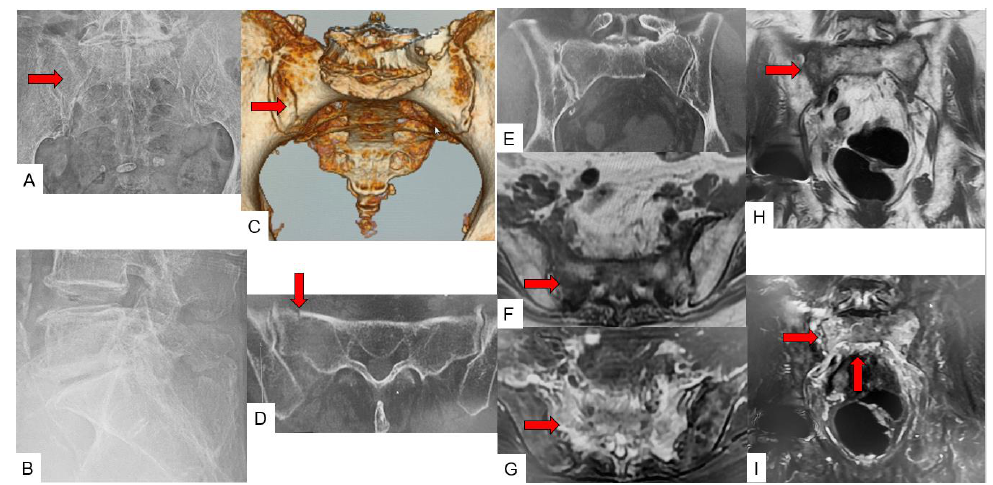
Figure 7. 87-year-old woman, λ/T-type fracture of SIF. ( A ): Anteroposterior radiograph, ( B ): Lateral radiograph, ( C ): 3D CT, ( D ): Axial CT, ( E ): Coronal CT, ( F ): Axial T1-weighted MR image, ( G ): Axial fat-suppressed T2-weighted MR image, ( H ): Coronal T1-weighted MR image, ( I ): Coronal fat-suppressed T2-weighted MR image, red arrows indicate fracture line. Case 2: 57-year-old woman, H/U-type fracture of SIF (Figure 8).